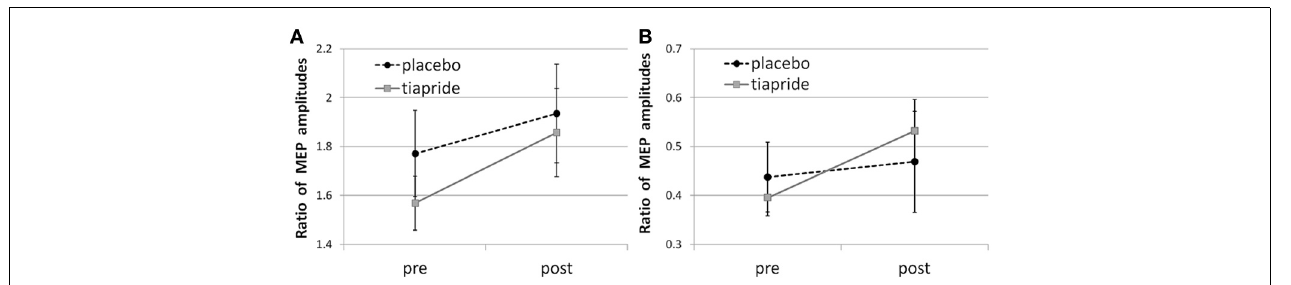
FIGURE 2 | Cortical excitability in the tiapride and placebo groups before and after learning and training of the motor sequence task. Mean CE is expressed as the ratio of MEP amplitudes in